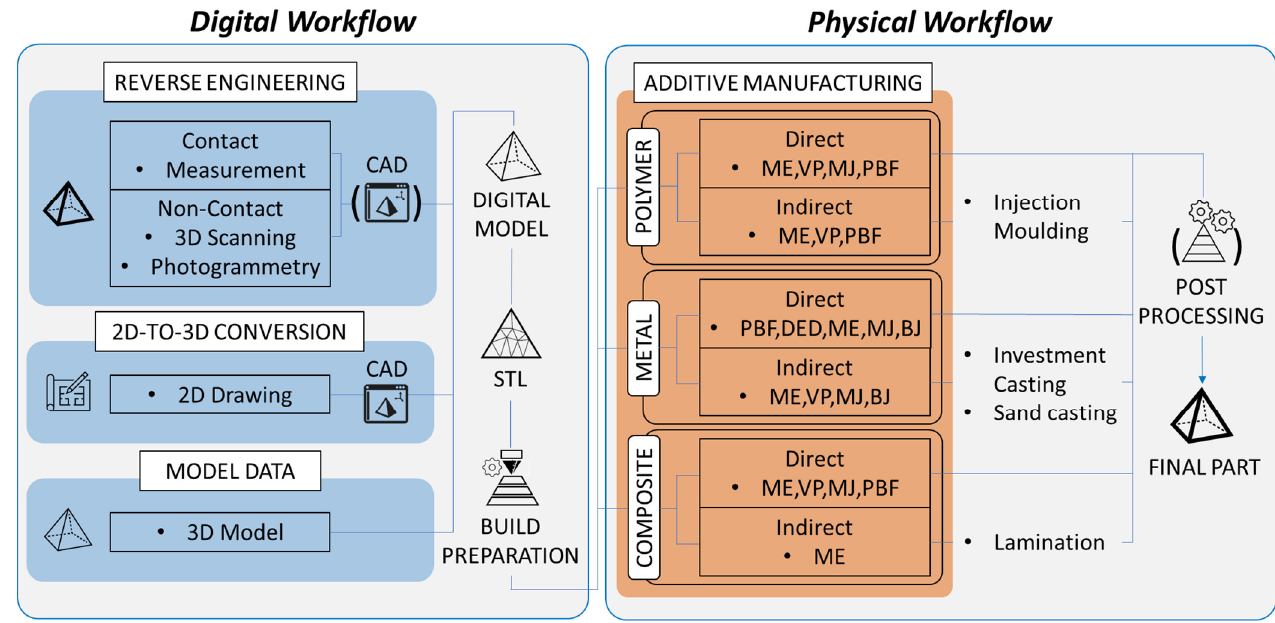
Figure 9. The framework of component reconstruction based on AM.